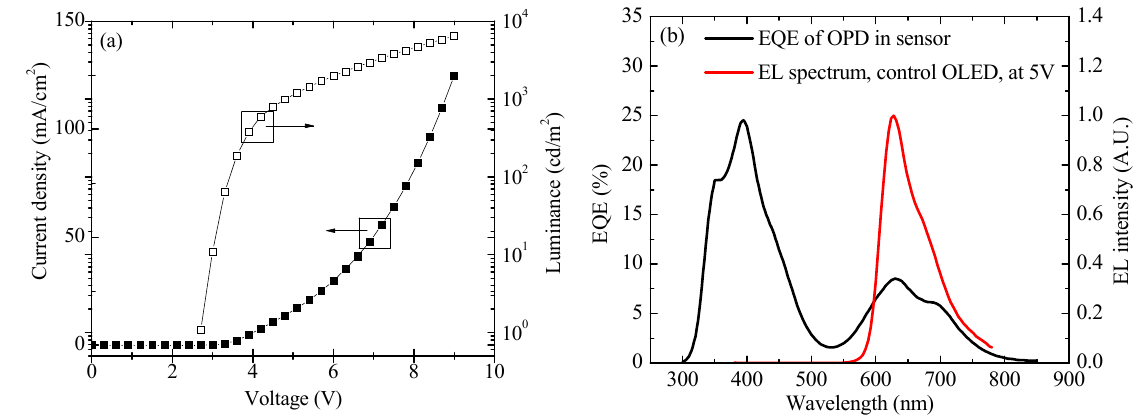
Figure 4. ( a ) Current density-voltage and luminance-voltage characteristics of the control OLED; ( b ) EL spectrum of the control OLED and external quantum efficiency (EQE) of the integrated OPD.